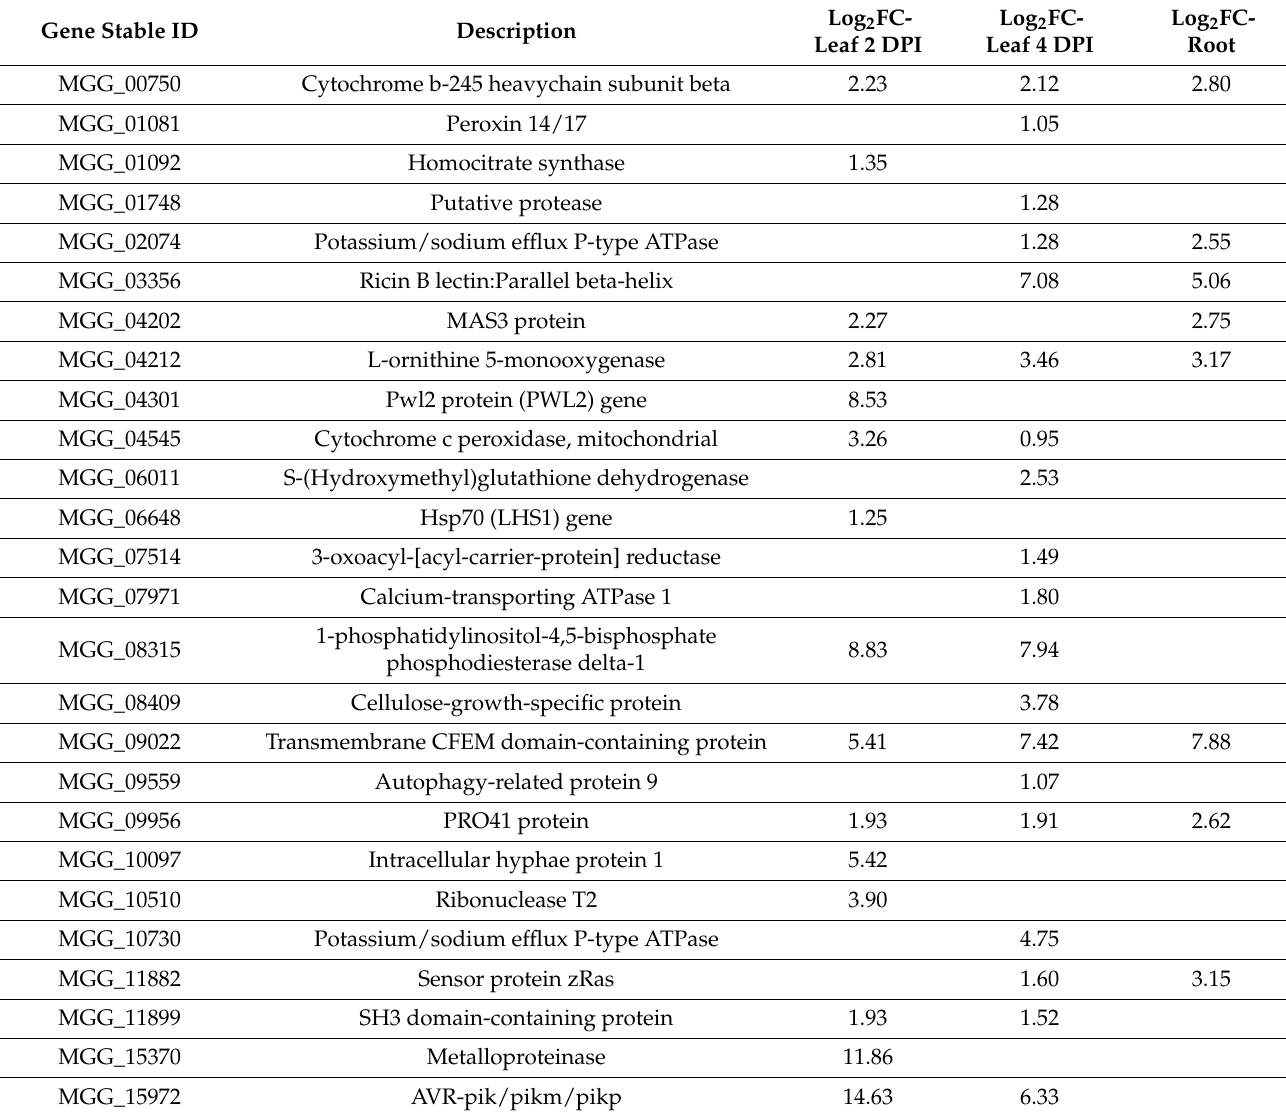
Table 3. Selected significantly (padj < 0.05) upregulated pathogenicity-/virulence-related M. oryzae genes during B. distachyon leaves and roots infection. Gene Stable